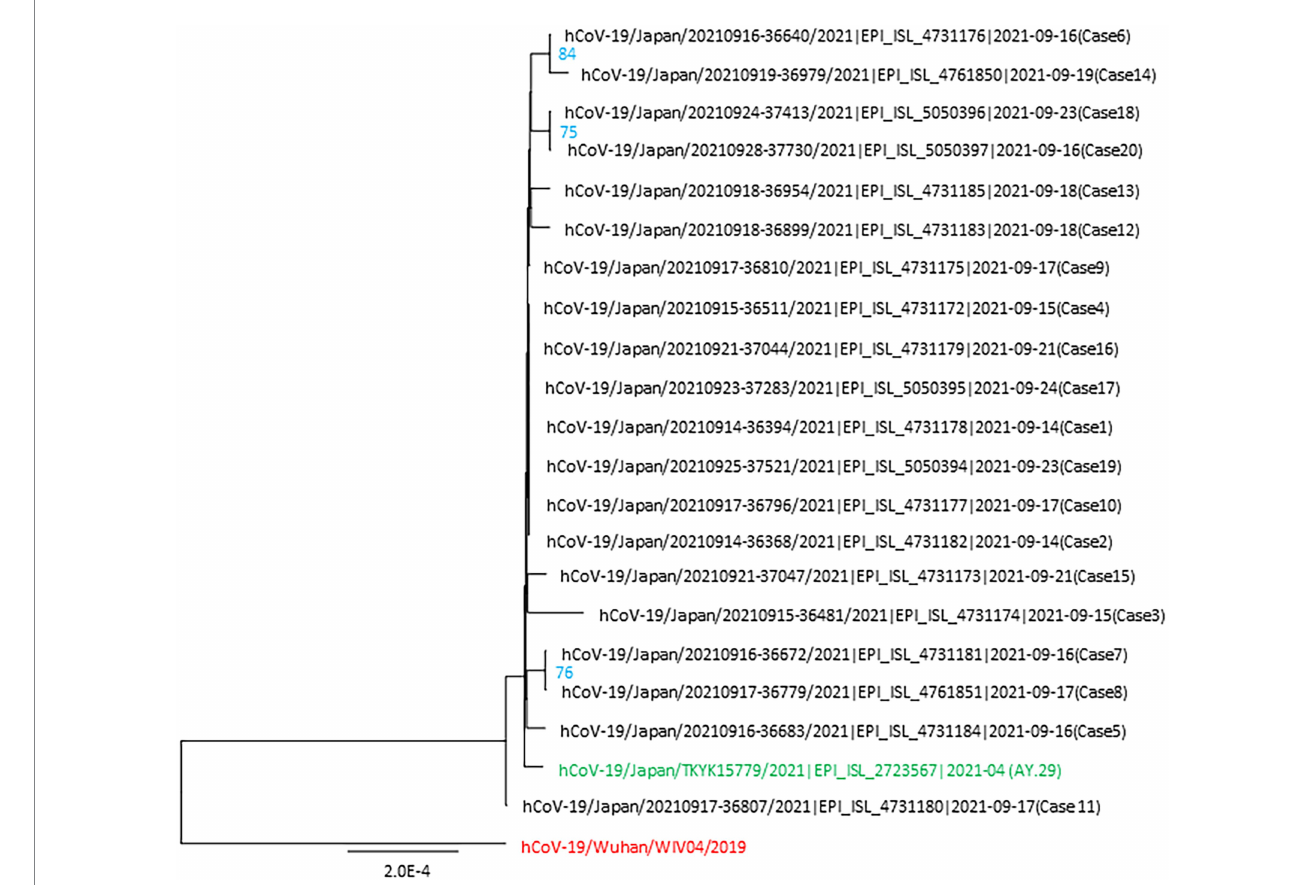
FIGURE 3 Phylogenetic tree of the SARS-CoV-2 genomes identified in the nosocomial cluster. This tree includes 20 viral genomes associated with the cluster, the first wild-type strain hCoV-19/Wuhan/WIV04/2019 and AY.29 wild-type strain hCoV-19/Japan/TKYK15779/2021 was used as the references. Each genome from the cluster is indicated with the virus name, accession ID of GISAID, and the case number. The ultrafast bootstrap support values of more than 70% were shown in the constructed